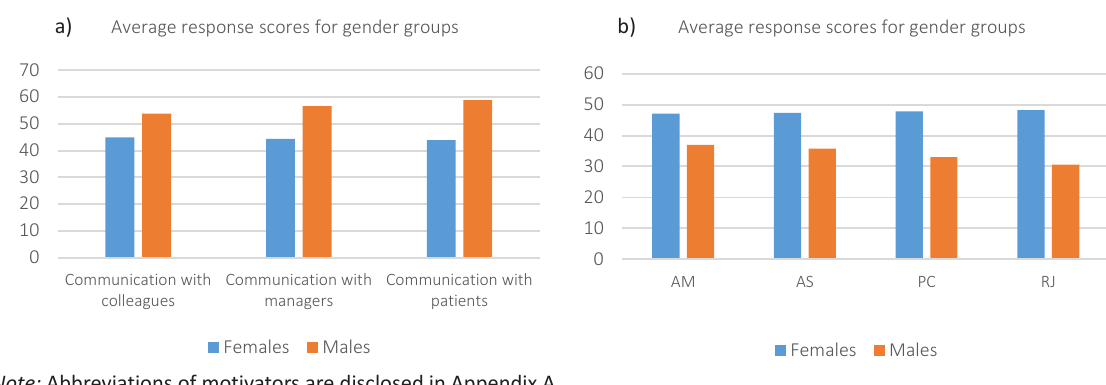
Figure 3. Significant differences between responses of gender groups on work conditions and motivation among all the observed medical